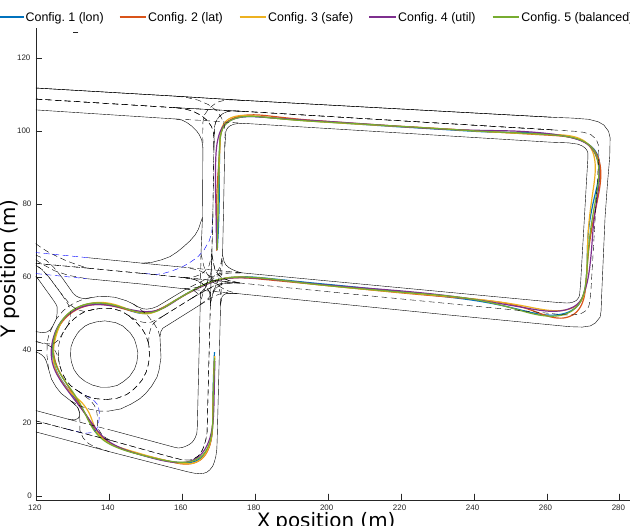
Figure 25. Final trajectories for the different configurations in the real environment.